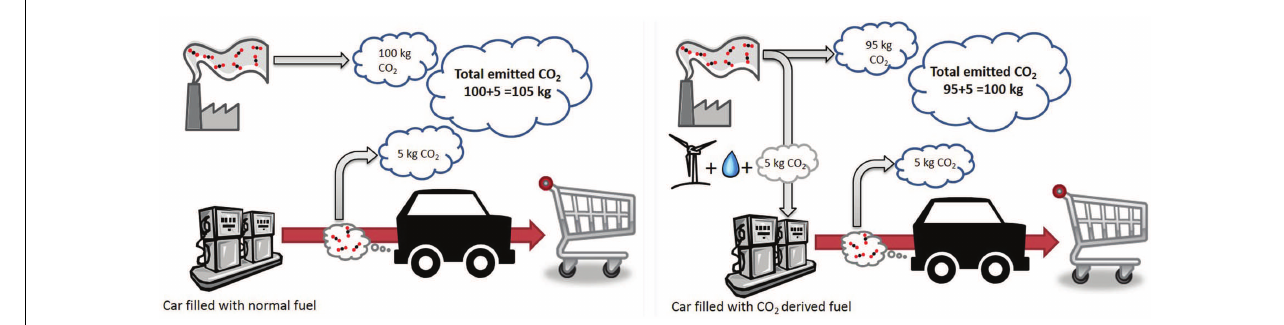
FIGURE 2 |The concept of avoided carbon . Emissions based on no carbon capture and fossil-derived transport fuel (left) and no capture but 5% conversion of industrial emissions into synthetic transport fuel (right).